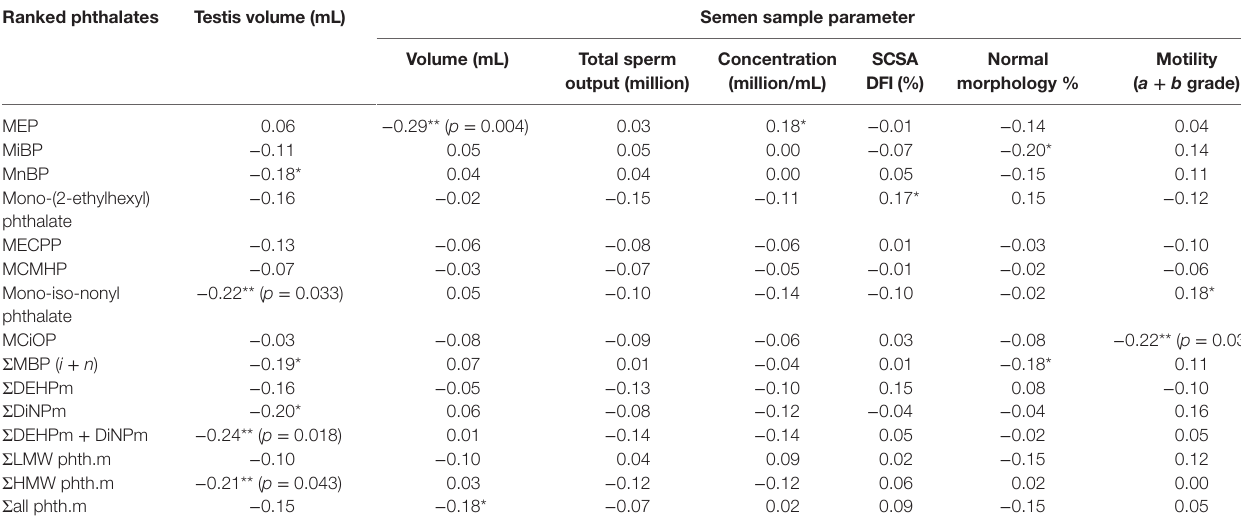
All correlations are adjusted for abstinence period, presence of a varicocele, maternal smoking and BMI at 20 years of age. Testicular volume was also adjusted for adult height z- scores (n = 91 to 94 for the parameters measured in adulthood). Uncorrected p-values are shown as **p < 0.05 and *p < 0.10. No statistically significant correlations were found after adjustment for multiple comparisons (105 = 7 outcomes × 15 phthalates) and no p-values < 0.00048 were found. SCSA DFI, sperm chromatin structural assay DNA fragmentation index.